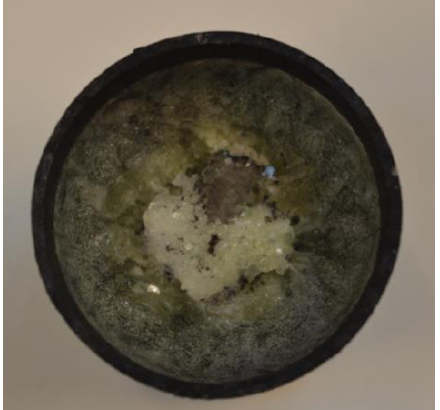
Figure 10. Cutting of the sample after testing.